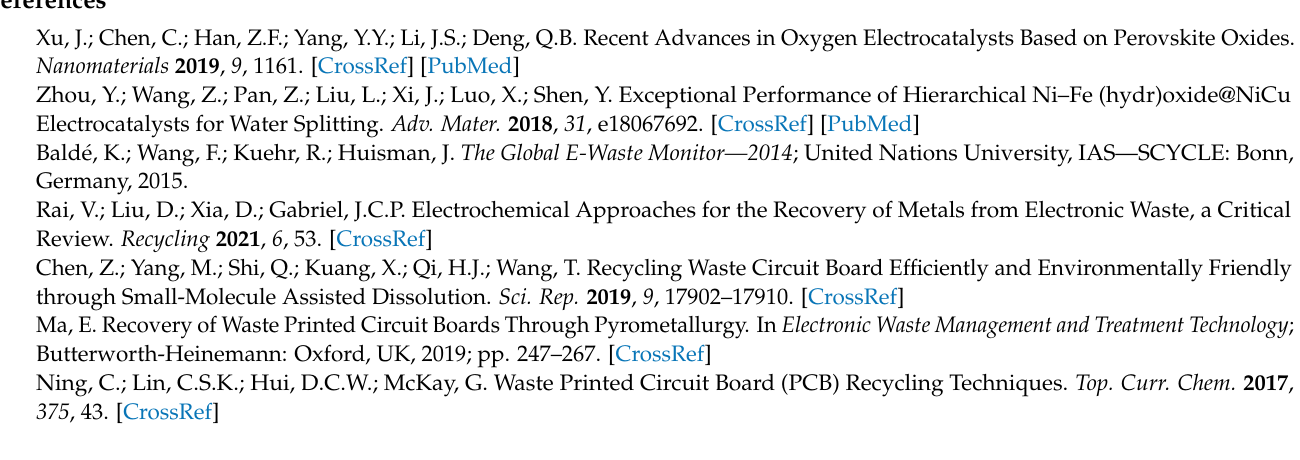
Figure S5. (a) SEM image of NiCu-hydroxide catalyst. (b), (c) and (d) the corresponding SEM-EDX element distribution images for O, Cu and Ni. (e) The element composition of NiCu-hydroxide catalyst, Figure S6. XPS spectra for NiFe-hydroxide: (a) full spectra; (b) C 1s peak deconvolution, Figure S7. XPS spectra of NiCu-hydroxide: (a) full spectra, and various peaks deconvolution (b) C 1s, (c) O 1s, (d) Cu 2p and (e) Ni 2p, Table S1. Metals analysis of scrubbed and regenerated ionic liquid from Zone 3 and zone 4, Table S2. Metals analysis of Pb selective precipitation from the Ni, Fe and Pb and Ni, Cu, Pb HCl back-extraction solutions from Zone 3 (stream 1) and Zone 4 (stream